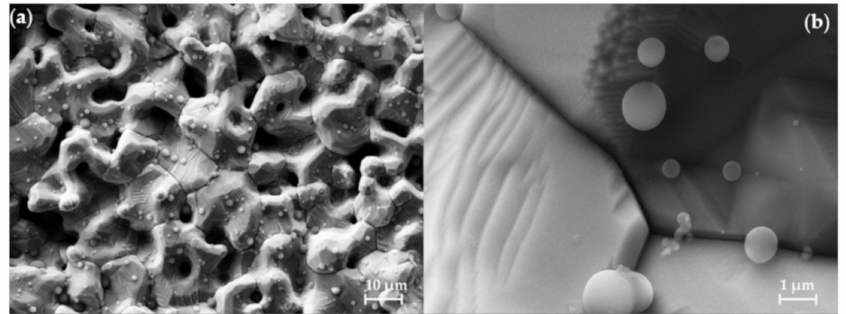
Figure 7. SEM Analysis of a post-HIP sample. After HIP treatment the 50 / 50 Ni / NiO precursor part was cut and examined in the SEM. It shows no voids equivalent to those observed pre-HIP (Figure 5). ( a ) Low magnification area image and ( b ) higher magnification image showing triple-junction.